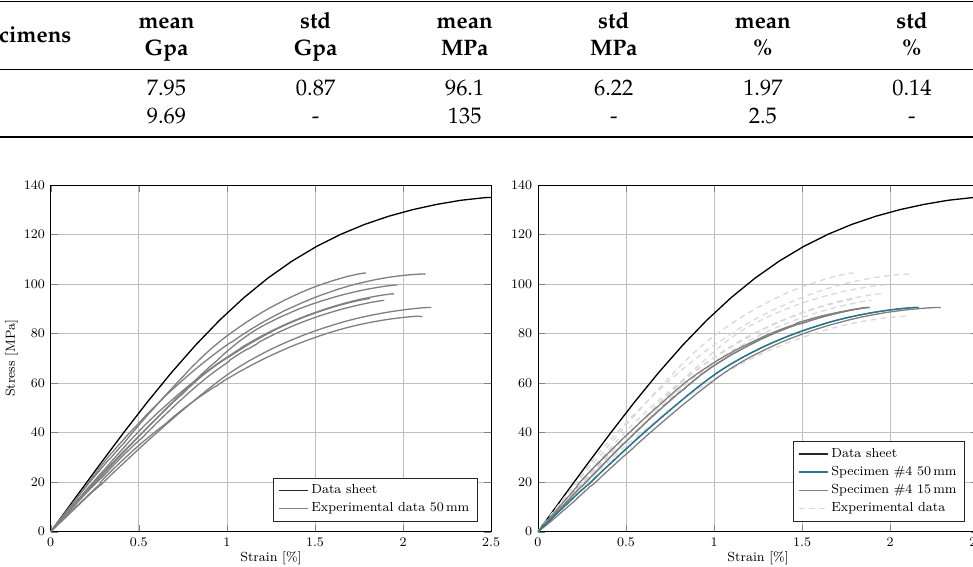
Table 1. Experimental results obtained by tensile tests in the elastic and plastic domain. E σ failure (cid:101) failure